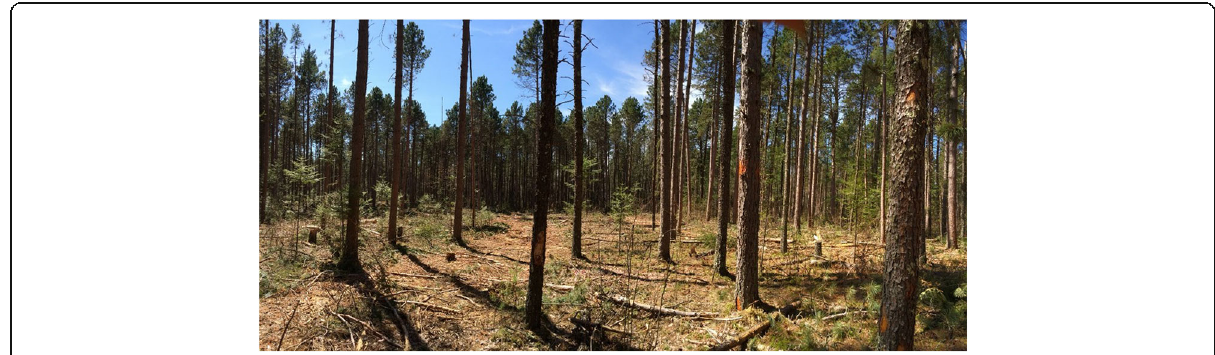
Fig. 9 Large gap/intact matrix configuration of VRH in a red pine stand on the Chippewa National Forest, USA. The photo looks into an approximately 0.2 ha opening. (Circa 2016)